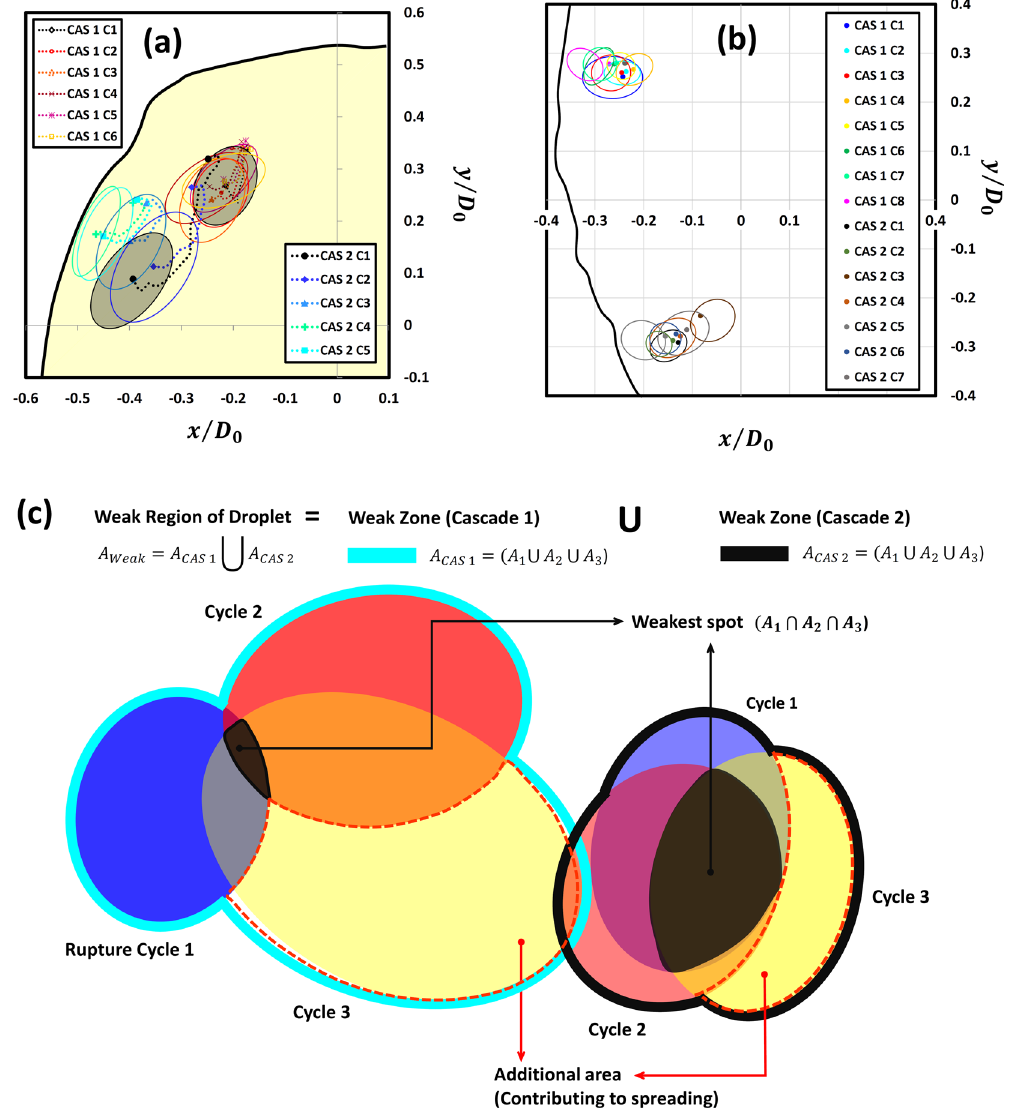
Figure 8. Spatial shifting of rupture sites (with each cycle) during an oscillatory cascade for: ( a ) 3 wt.% gellant loading and ( b ) 5 wt.% gellant loading. ( c ) Schematic showing a set theory based geometrical description of the rupture dynamics (locally at the droplet